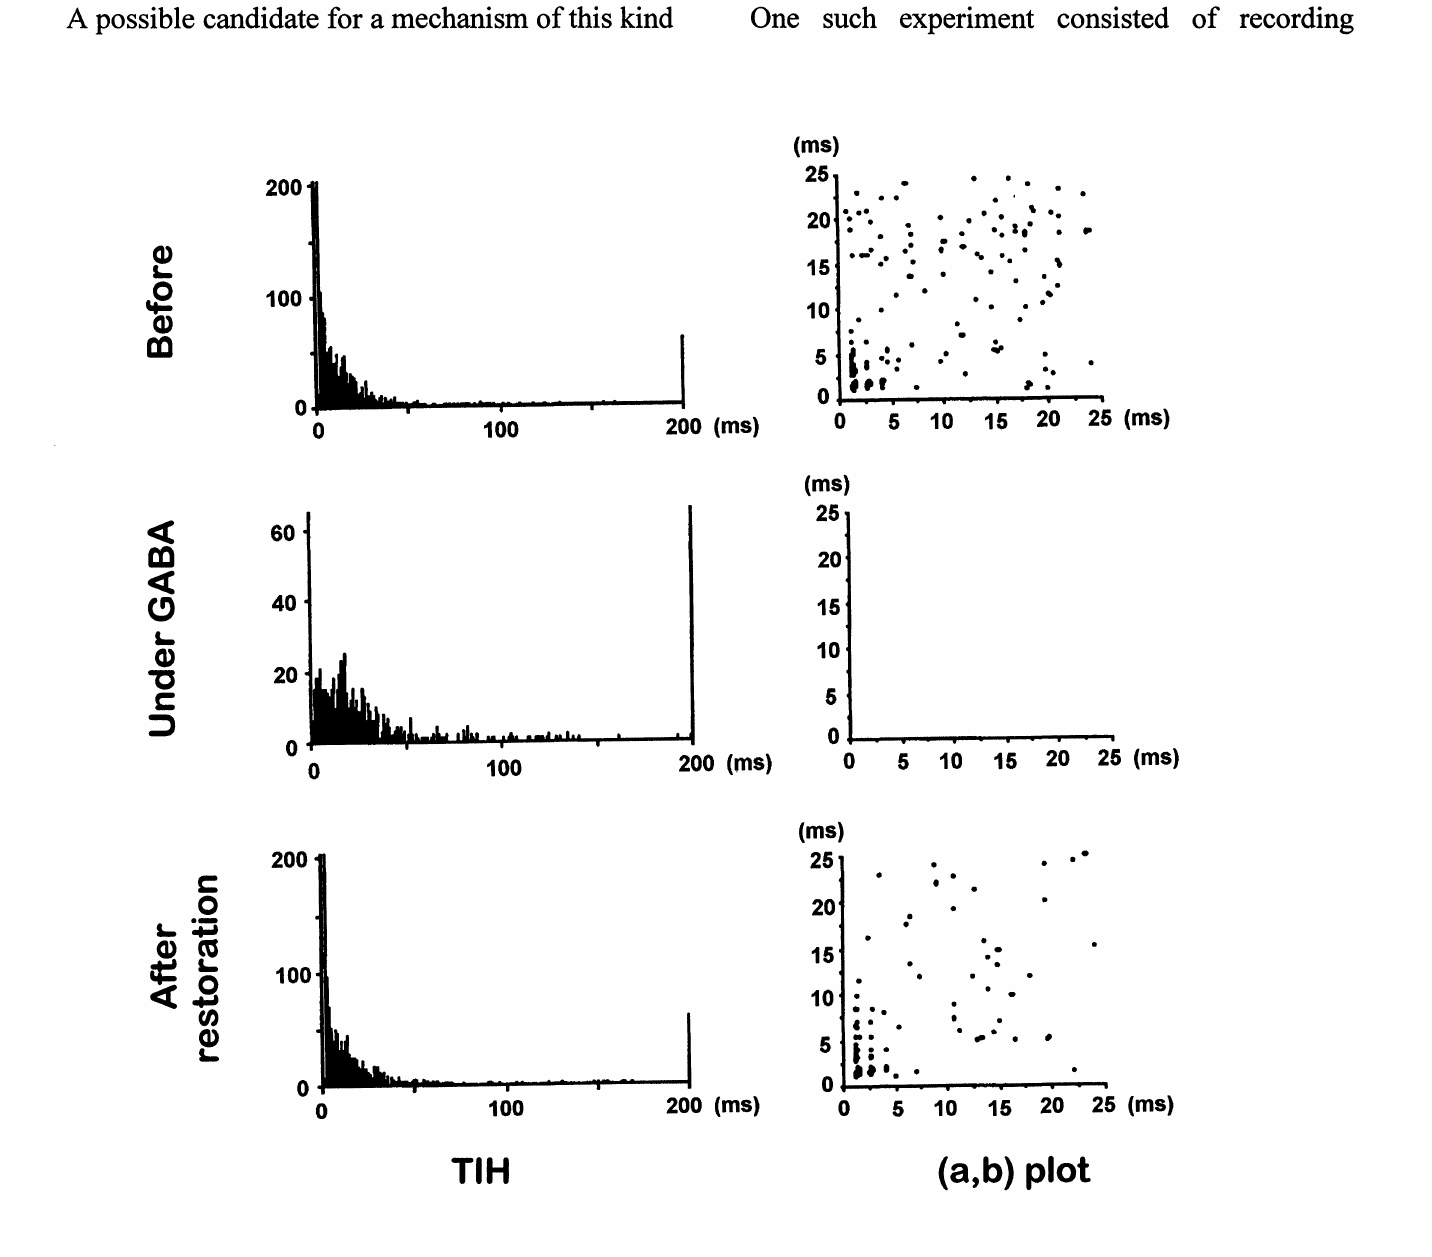
Fig. 9: Precisely replicating triplets detected in the LGN spike trains of an anaesthetized cat are disrupted during a cortical application of GABA. Temporal structure representations of replicating triplets detected in an impulse train before, during, and after a local cortical application of GABA. The record has been kept on 20 runs of 2.5 s duration each. Atter the injection of GABA, replicating triplets were no longer detected in the spike train. The bottom two-dimensional plot indicates an almost complete recovery of the triplet production after dissipation of GABA. The Time Interval Histogram (TIH) was only slightly and reversibly affected during GABA application. (From Beaux et al.,